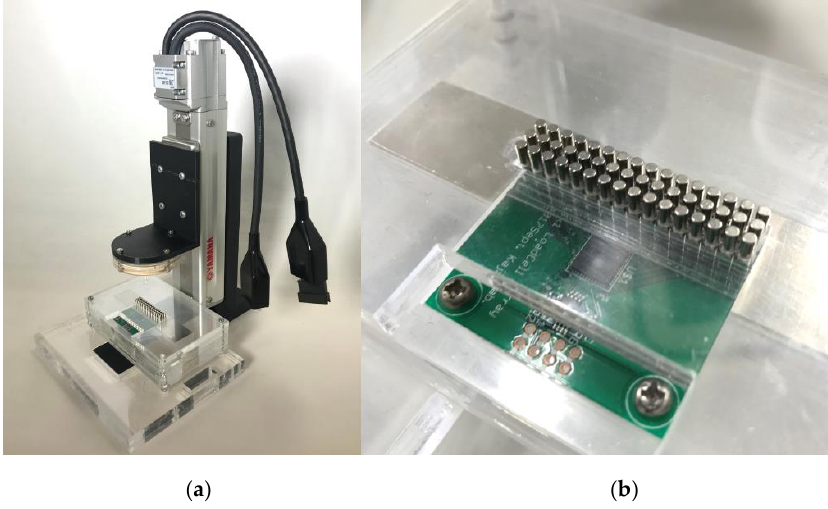
Figure 10. Single-column pin-array measuring device ( a ) overall view, ( b ) magnified view of the measurement